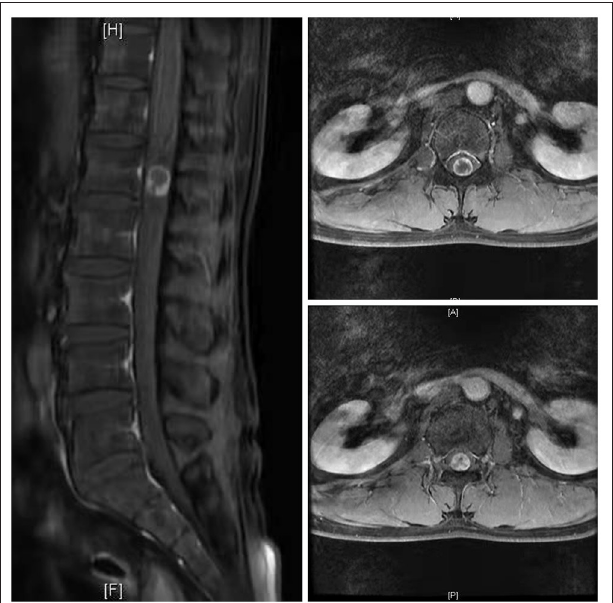
FIGURE 3 | Preoperative MRI of the case 1.